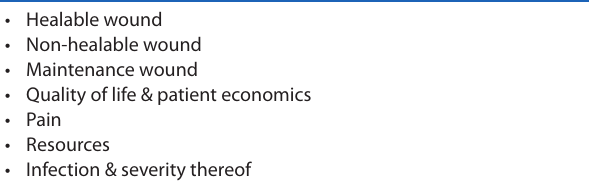
Table 11: factors influencing choice of dressings